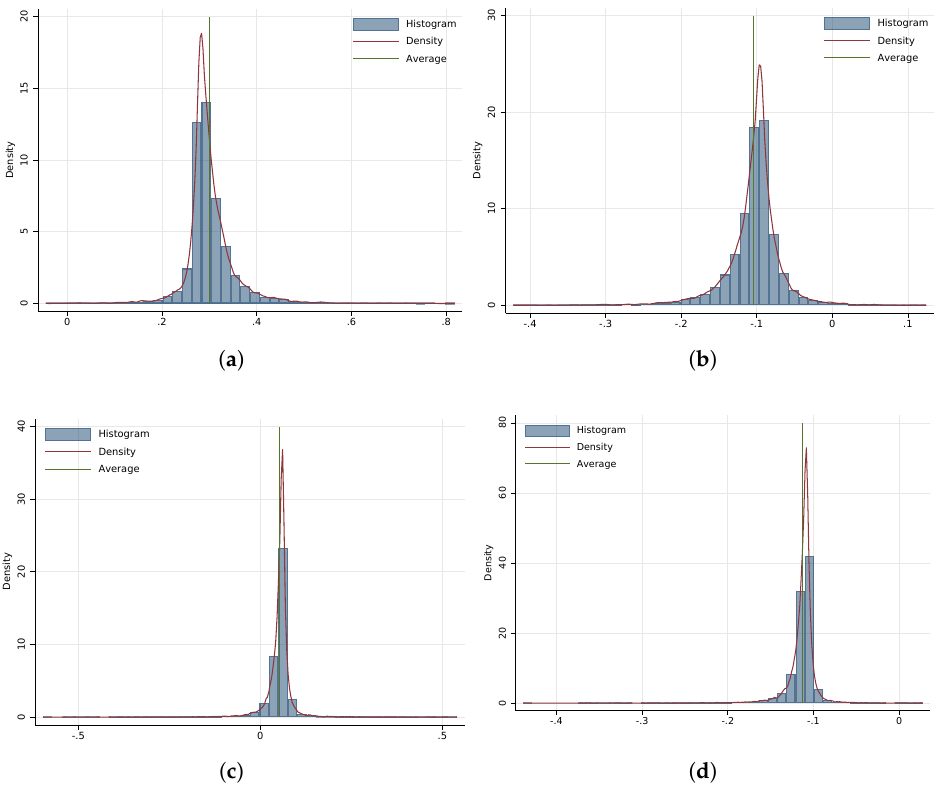
Figure 5. Unconditional distribution of estimates across partition simulations. ( a ) USA: Elasticity at average ( ˆ β ), ( b ) USA: Interaction ( ˆ γ ), ( c ) Brazil: Elasticity at average ( ˆ β ), ( d ) Brazil: Interaction ( ˆ γ